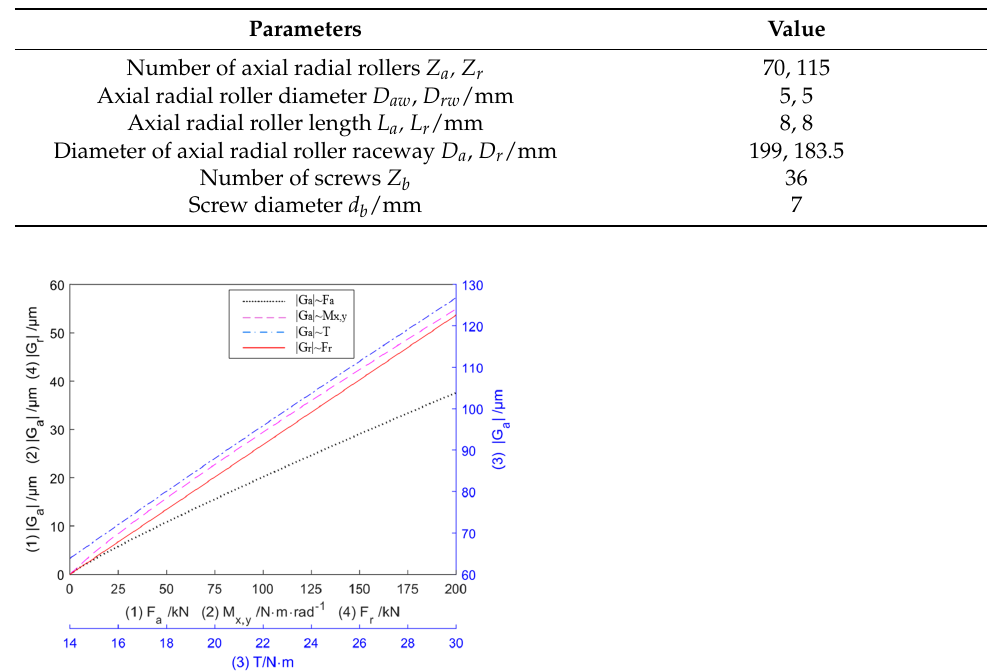
Figure 5. Variation of axial clearance | G a | with tightening torque T , external load axial force F a and torque M x,y .